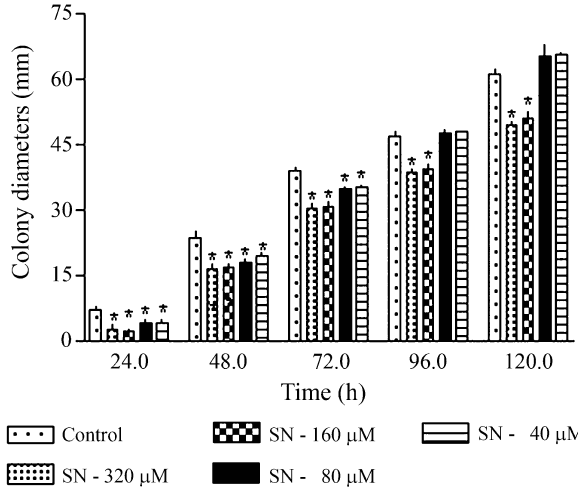
Figure 1 - Growth of A. nidulans strain A757 on plates containing Com- plete Medium plus various concentrations (0 (control), 40, 80, 160 and 320 (cid:1) M) of sodium nitroprusside. An asterisk (*) indicates that growth was significantly different from the control ( t test, p <